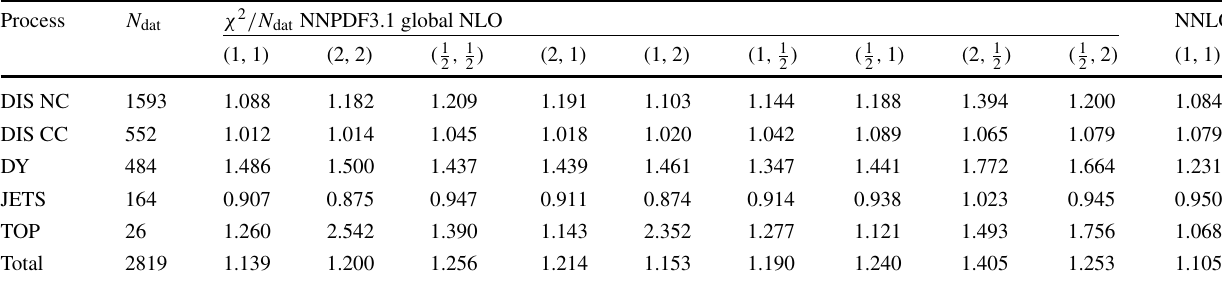
Table 15 Same as Table 14 for global PDFs Process